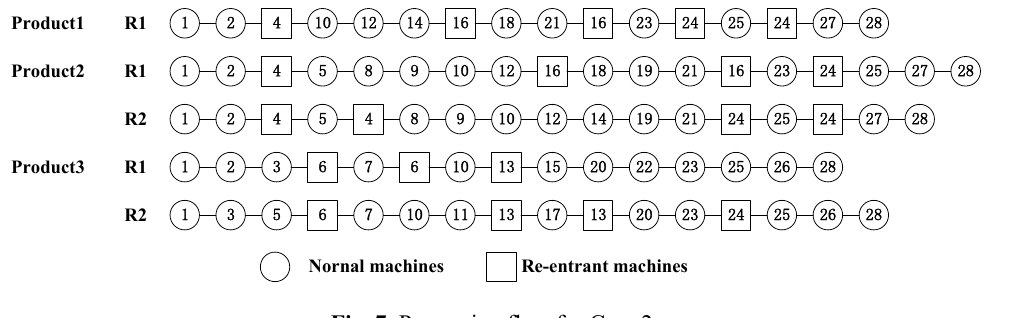
Fig. 7. Processing flow for Case